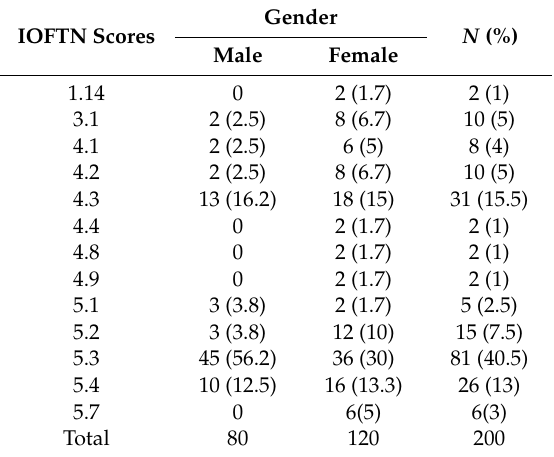
Table 2. Gender distribution of IOFTN